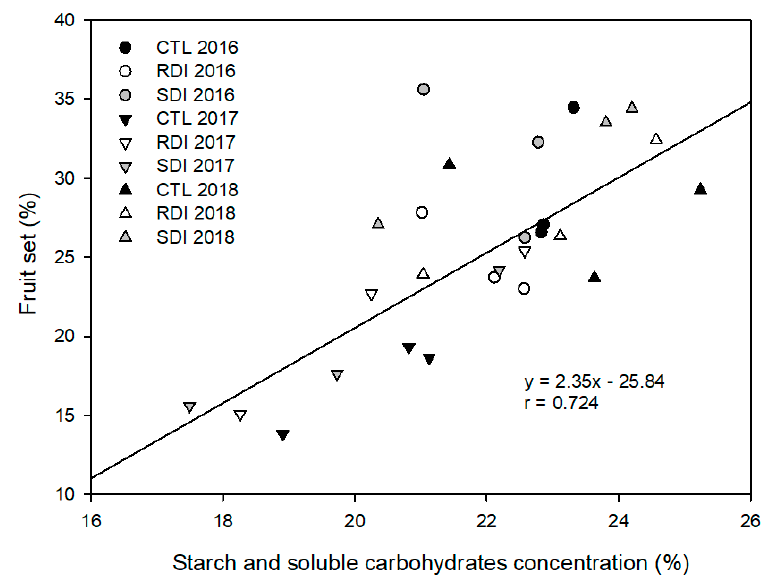
Figure 6. Relationship between starch and soluble carbohydrates concentration (%) in winter (January) and fruit setting in spring of the same year. Each observation corresponds to an average value for each block (n = 2).